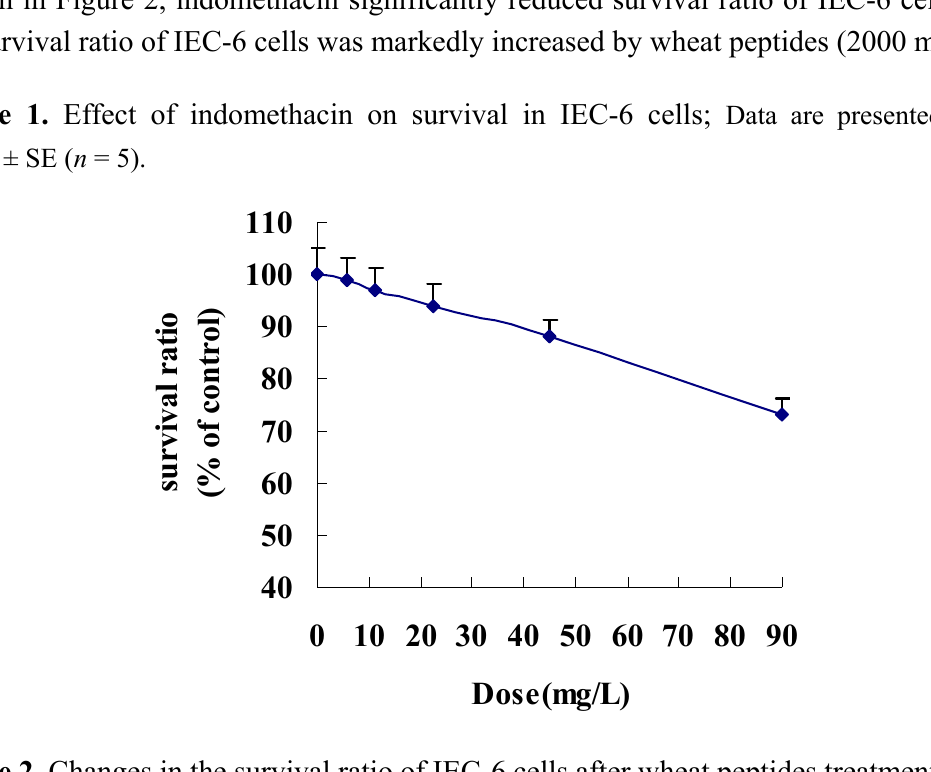
Figure 2. Changes in the survival ratio of IEC-6 cells after wheat peptides treatment. IEC-6 cells were pre-cultured in medium for 48 h, then treated with different doses of wheat peptides for 24 h, finally followed by indomethacin (90 mg/L) for 12 h. Data are presented as the means ± SE ( n = 5); * p < 0.05 significantly different from the normal control groups; # p < 0.05 significantly different from the model groups (the indomethacin